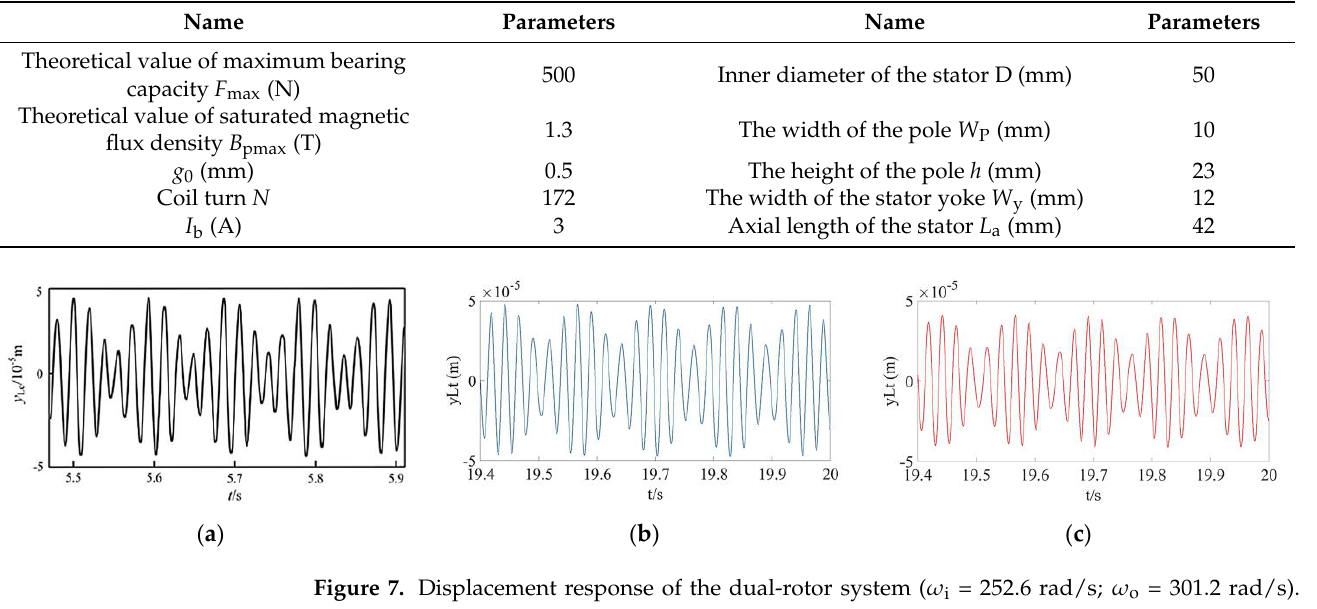
Table 2. Structure parameters of AMBs.